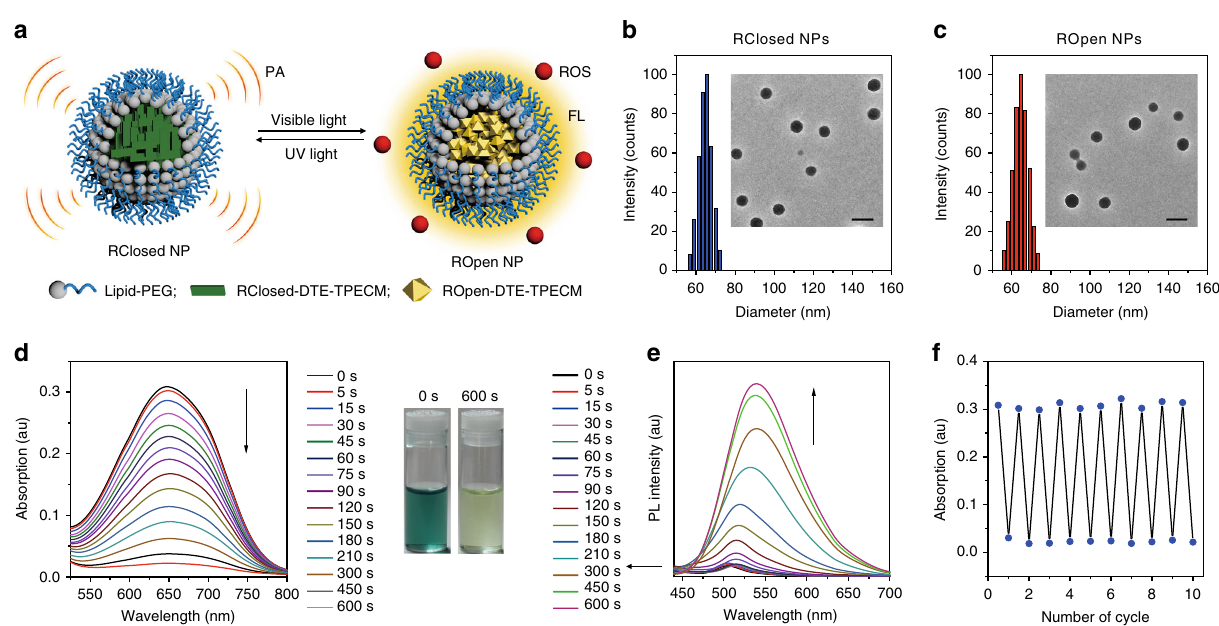
Fig. 3 Preparation and characterization of the photo-controllable NPs. a Schematic of RClosed NPs and ROpen NPs. b , c DLS pro fi les and TEM images of b RClosed NPs and c ROpen NPs. Scale bars, 100nm for TEM images. d Absorption and e PL spectra of RClosed NPs under visible light (610nm, 0.3Wcm − 2 ) irradiation for different time as indicated. Photographs in d indicate the aqueous solutions of RClosed NPs before and after 610nm light exposure for 600s. f The absorption intensity at 650nm of the NPs during ten circles of visible (610nm, 0.3Wcm − 2 )/UV light (365nm, 0.1Wcm − 2 ) irradiation using a 680 nm pulsed laser. At the same condition, the PA